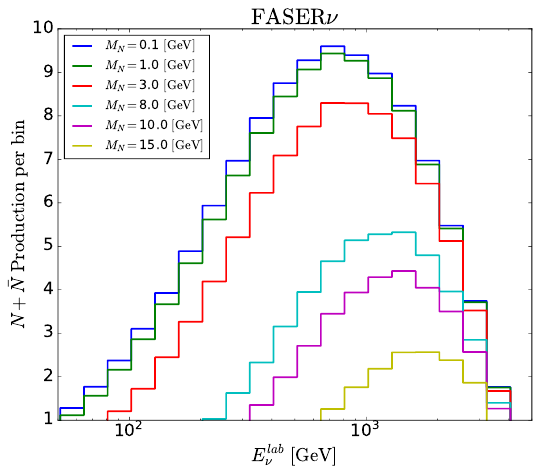
¯ N particles produced by muon neutrino and antineutrino fluxes